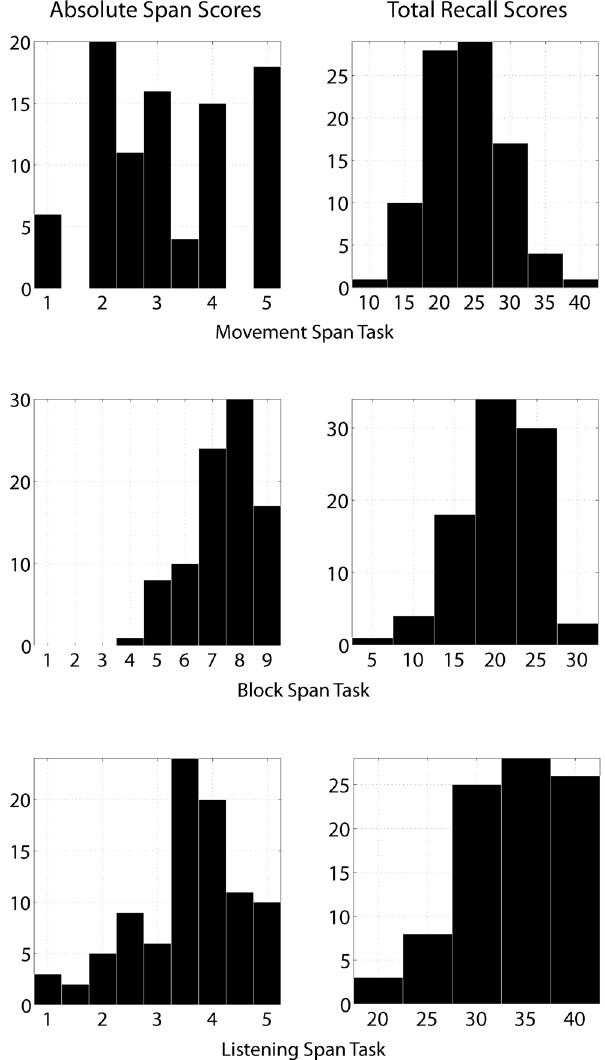
Figure 3. Histograms of absolute span and total recall scores. Note that mean recall scores reflect total items for the movement and sentence span tasks, whereas they reflect the number of correctly reproduced sequences for the Corsi block task.